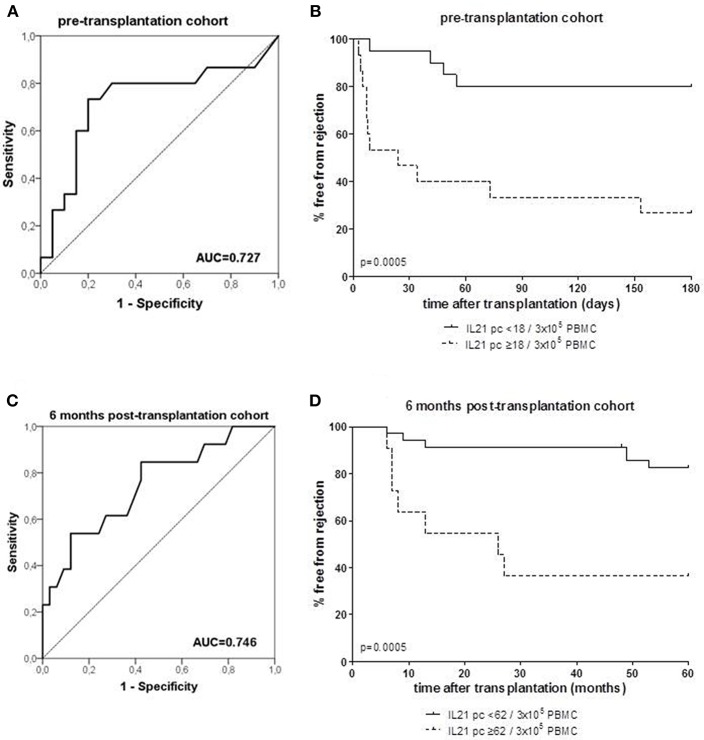
Receiver operating characteristic (ROC) analysis was performed to define the cut-off number of donor-specific IL-21 producing cells (pc) (A: PBMC samples taken from patients prior to transplantation; C: PBMC samples taken from patient at 6 months after transplantation), and discriminated between patients with and without rejection. A cut-off of 18 spots per 300.000 PBMCs was determined with a specificity of 80% and a sensitivity of 73% in the pre-transplant cohort (A), and a cut-off of 62 spots per 300.000 PBMCs was determined with a specificity of 88% and a sensitivity of 54% in the 6 months post-transplant cohort (C). Thereafter, the percentage of patients with high and low numbers (cut-off values) of IL-21 pc free from rejection were determined in the pre-transplant (B) and post-transplant cohort (D). AUC, area under the curve.